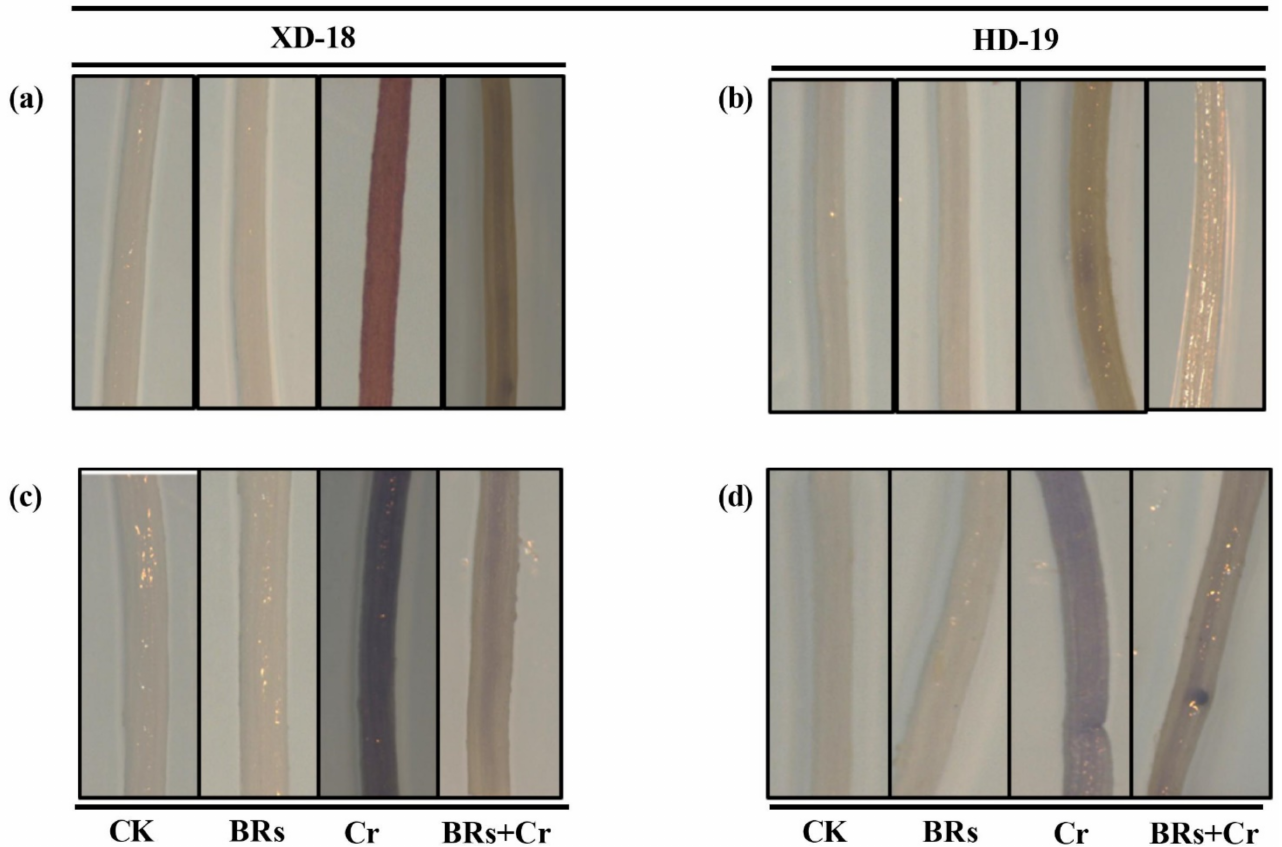
Figure 6. Effects of foliar-applied BRs on the histochemical staining to identify the accumulation of ( a ) hydrogen peroxide (H 2 O 2 ) in the roots of XD-18, ( b ) hydrogen peroxide (H 2 O 2 ) in the roots of HD-19 by 3, 3-diaminobenzidine (DAB), ( c ) superoxide (O 2 •− ) in the roots of XD-18, and ( d ) super- oxide (O 2 •− ) in the roots of HD-19 by nitro blue tetrazolium (NBT) against chromium (Cr) (0 and 100 µ M)